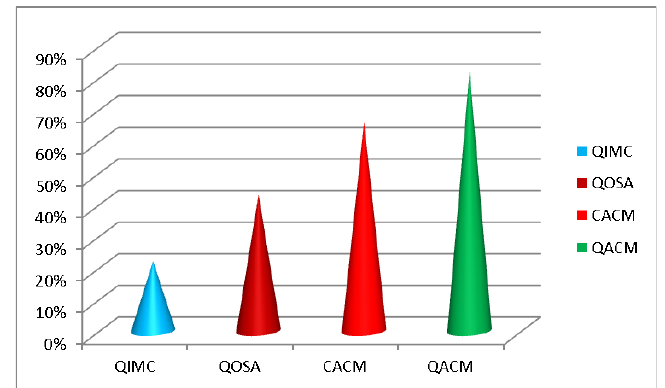
Figure 4. Crowd sensing efficiency